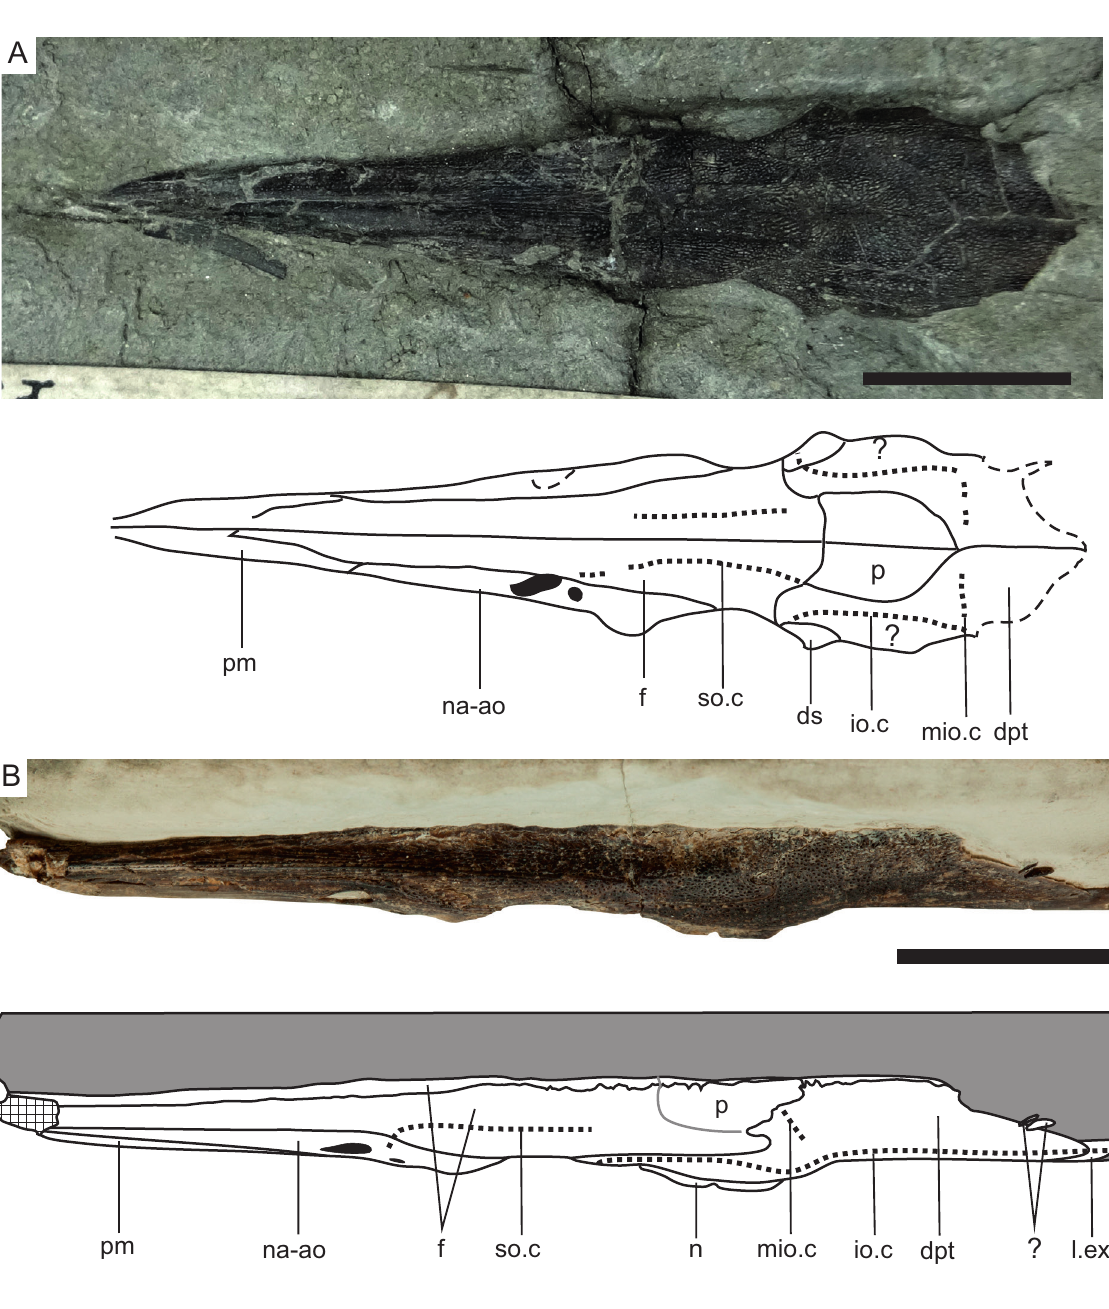
Fig. 3. Dorsal skull roof. A . Saurorhynchus anningae sp. nov. (NHMUK PV P 964); note that this skull has been dorsoventrally compressed. B . Saurorhynchus hauffi sp. nov., three-dimensionally preserved skull GG 20001. Fine dashed lines indicate sensory canals, large dashes indicate broken or incomplete areas; grey lines indicate bones that were present but where the exact location of the sutural contact is unclear, and question marks indicate areas of uncertainty. Abbreviations: dpt = dermopterotic; dsp = dermophenotic; f = frontal; io = infraorbital; io.c = infraorbital sensory canal; l.ex = lateral extrascapular; mio.c = medial branch of the infraorbital sensory canal; n = neomorph; na-ao = nasaloantorbital; p = parietal; pm = rostropremaxilla; so.c = supraorbital sensory canal. Scale bars = 10 mm. A. Photo © The Trustees of the Natural History Museum,